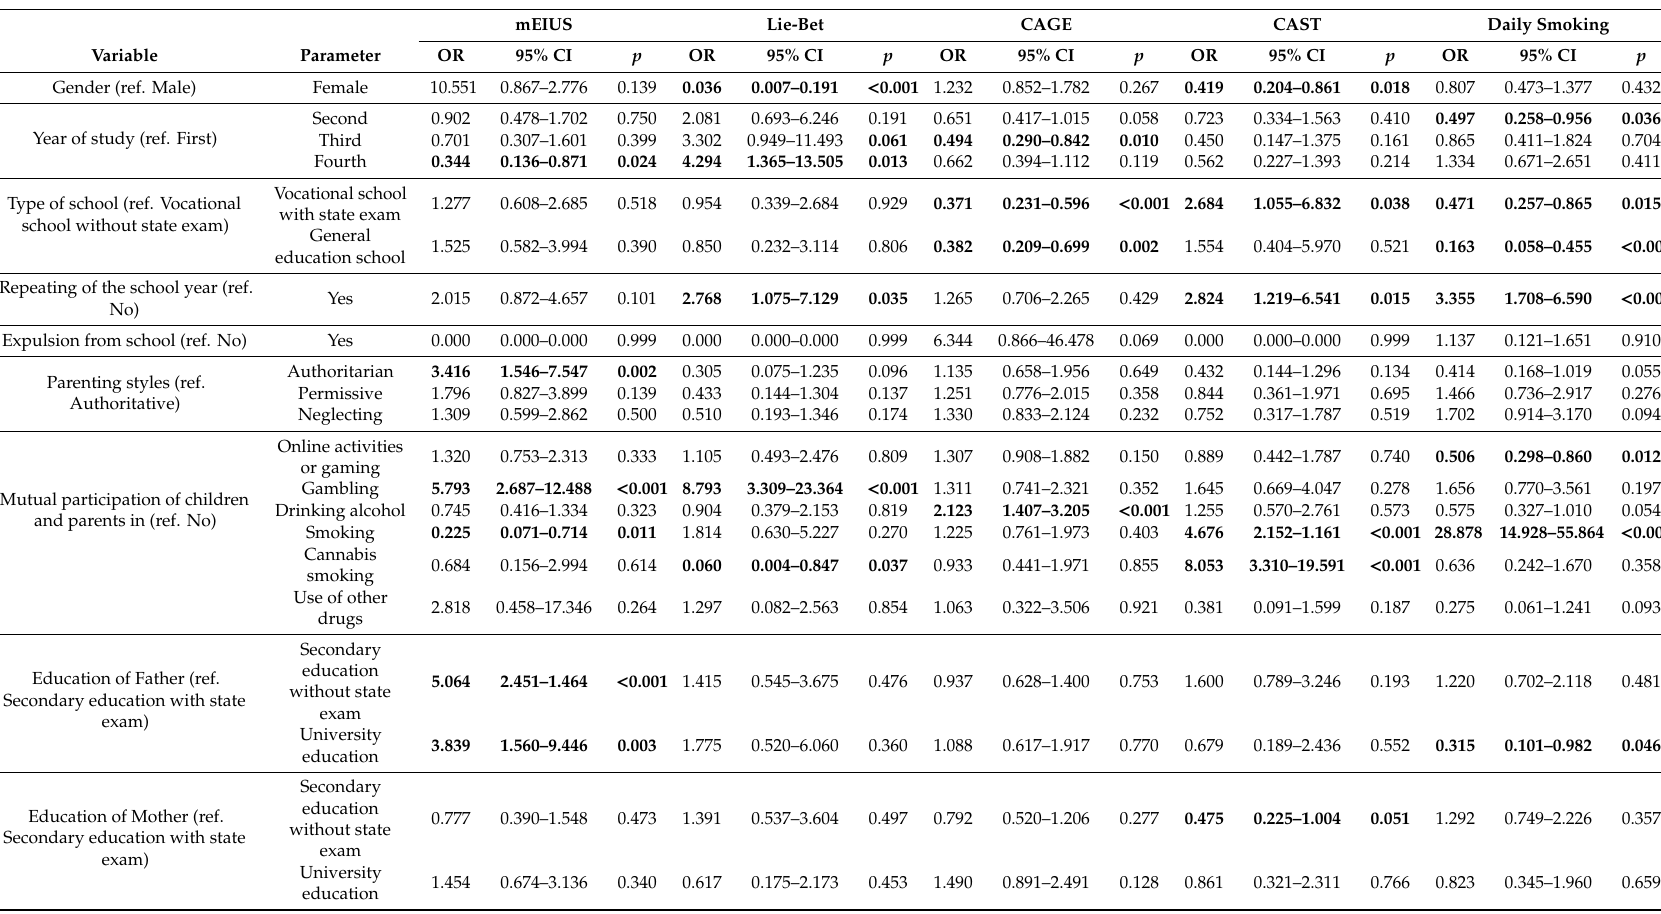
Table 2. Multinomial logistic regression predicting likelihood of problem behavior—mEIUS, Lie-Bet, CAGE, CAST, and daily smoking. mEIUS